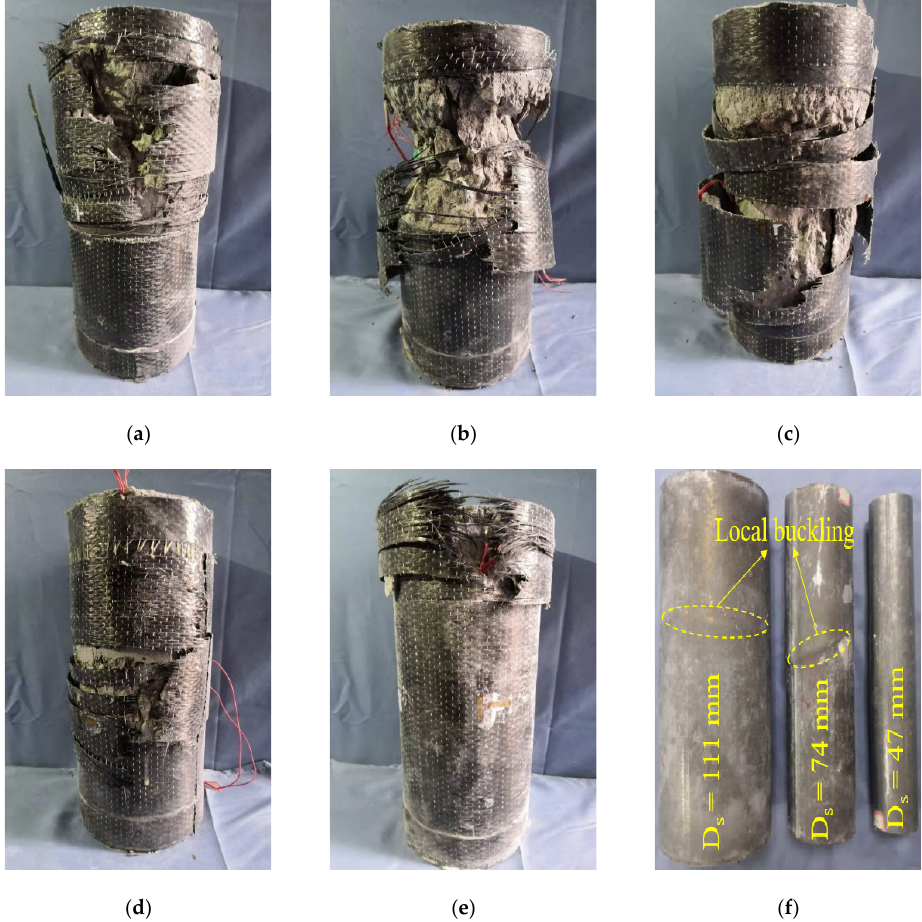
Figure 7. Typical failure modes of experimental specimens: ( a ) H0F2; ( b ) M47F1-1; ( c ) M74F2-1; ( d ) M111F2-2; ( e ) H111F2-2; ( f ) inner steel tube in DTCC.